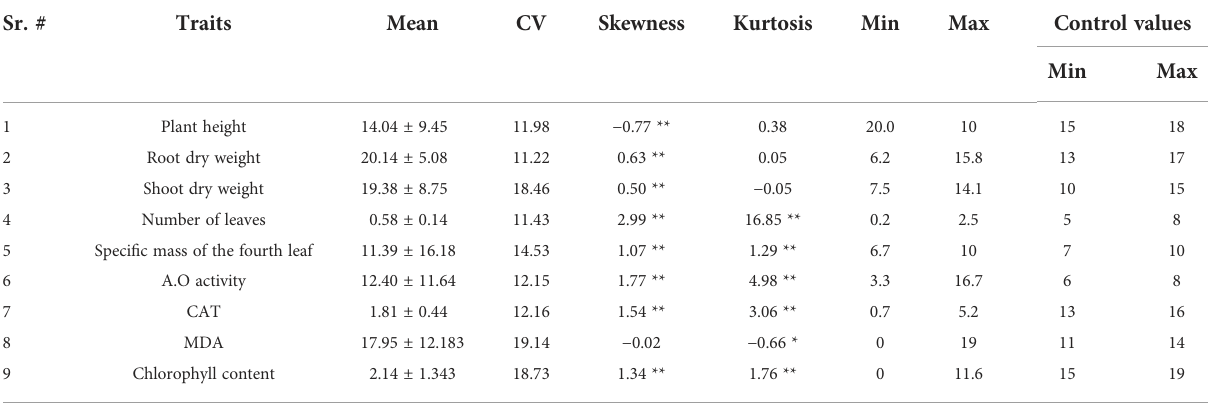
TABLE 3 Morphological and physiological trait